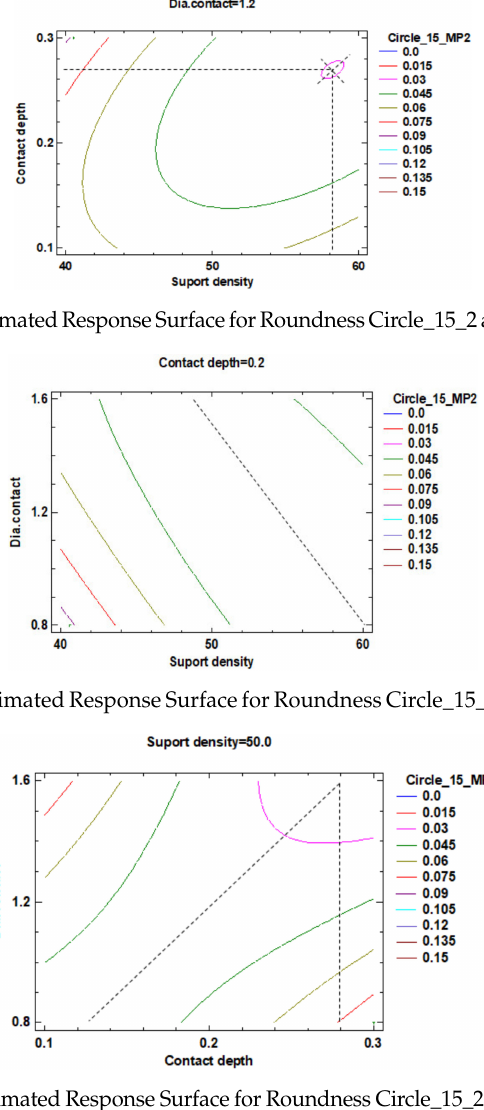
Figure 37. Contours of Estimated Response Surface for Roundness Circle_15_2 and centre support